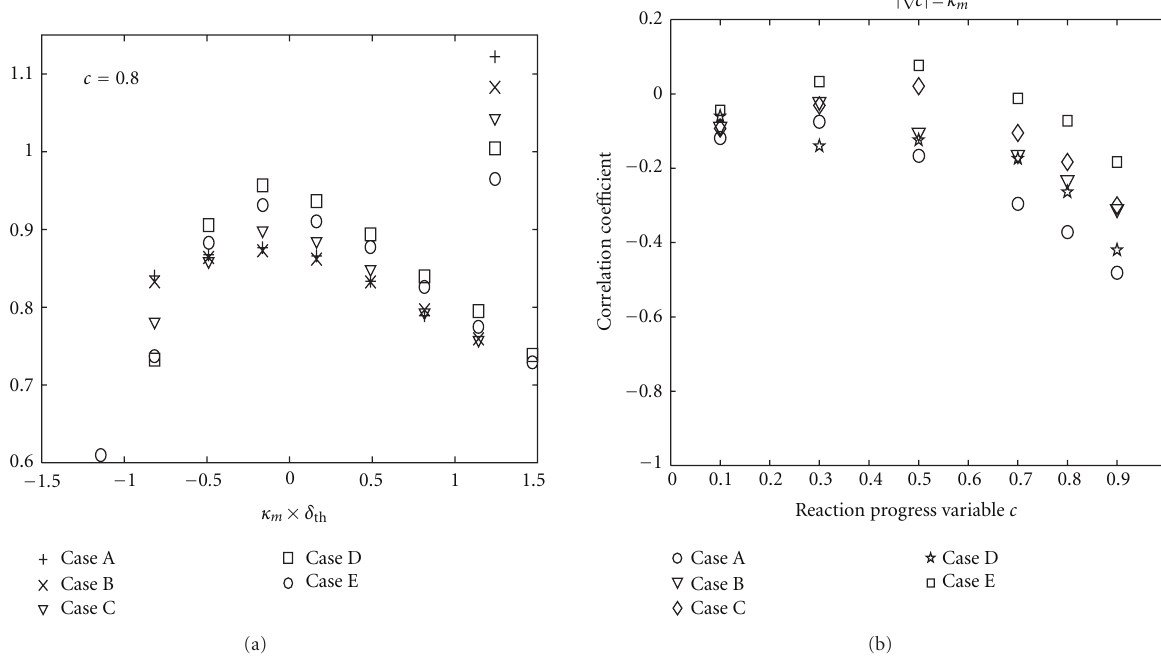
Figure 6: (a) Variation of mean values of |∇ c | × δ th conditional on normalised curvature κ m × δ th for the isosurface at c = 0.8. (b) Variation of the correlation coe ffi cients between |∇ c | and κ m on the isosurfaces at c = 0.1 to 0.9 for all